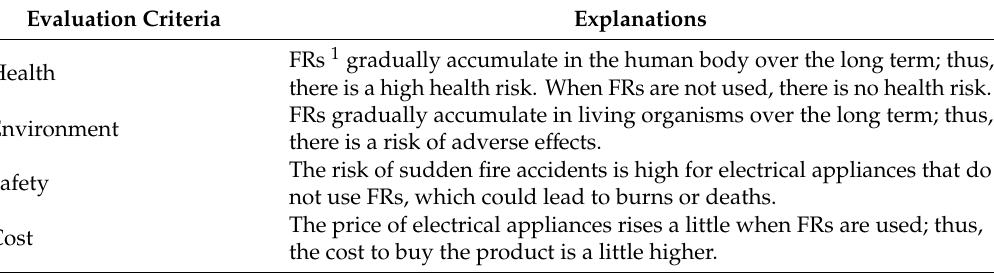
Table 2. Explanation of evaluation criteria.